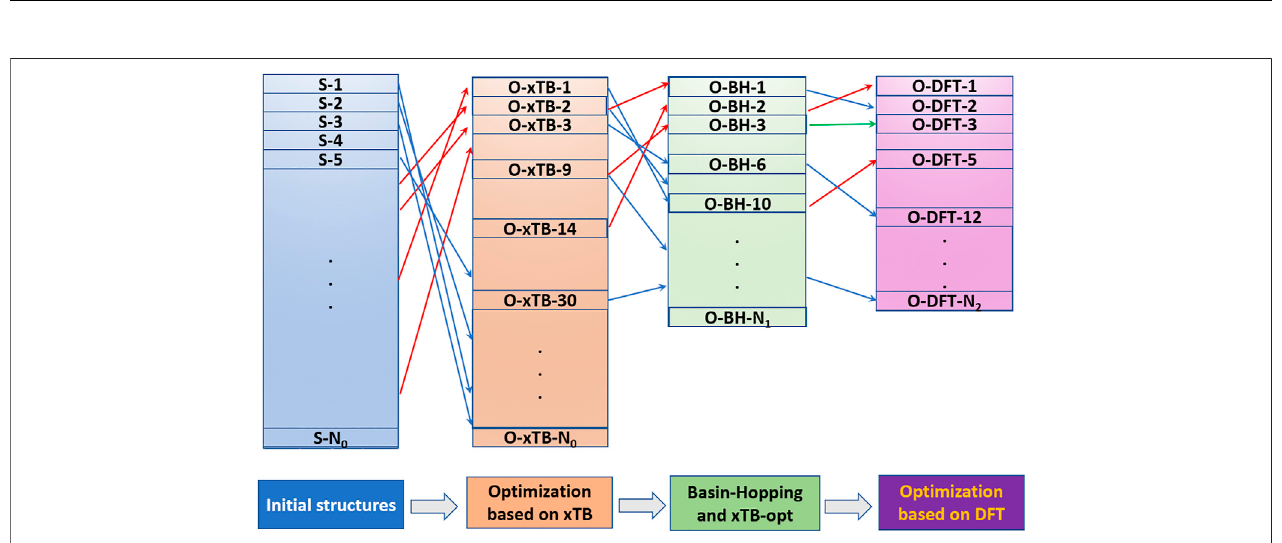
FIGURE 1 | The procedure of the whole program is shown in the middle. The left side shows the process of building initial structures, and the right side shows the detail of the basin-hopping algorithm applied here.